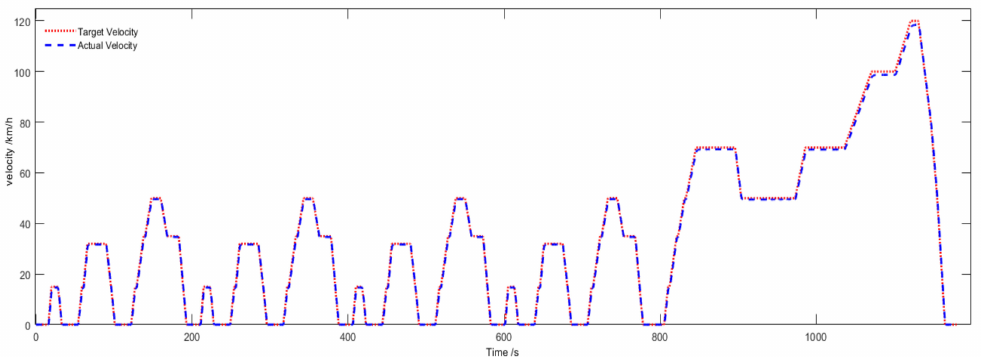
Figure 9. The target velocity and actual velocity.